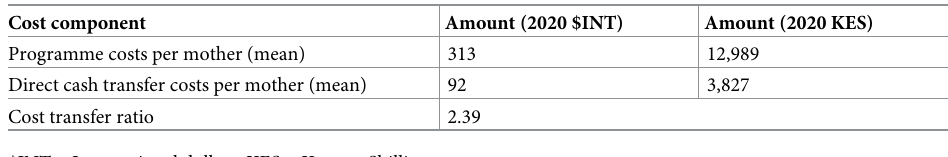
Table 2. Cost-efficiency